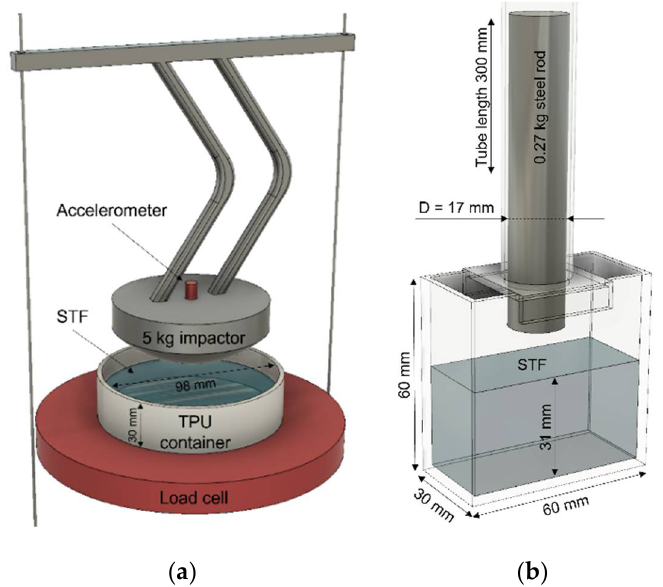
Figure 2. Illustrations of low-velocity impact setups. ( a ) The drop weight impact setup with a custom 3d printed TPU container. All samples were filled to the 13 mm thickness level from the bottom. Height from the surface of STF to the tip of the hemispherical impactor was a controlled parameter. ( b ) The acrylic glass setup that was used together with a speed camera for the flow field analysis during impact. All samples were subjected to the impact from the same height (327 mm).